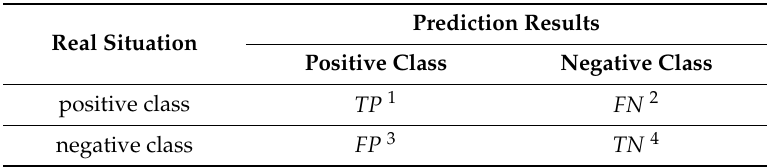
Table 4. Confusion matrix of classification